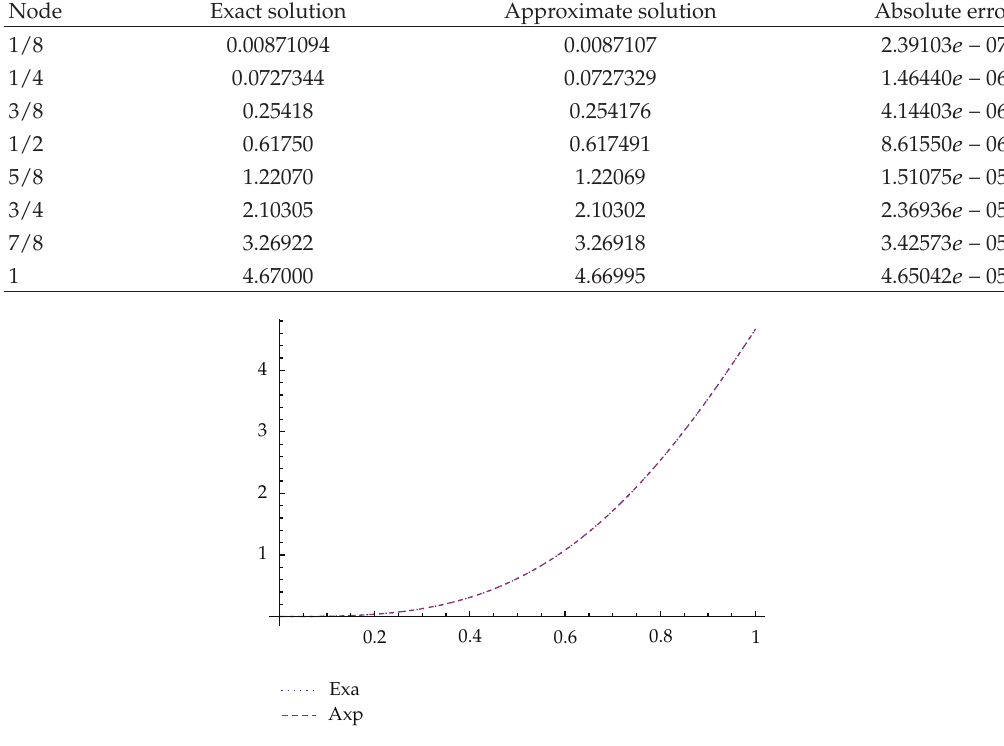
Figure 2: Comparison of the approximate solution u n (cid:6) x (cid:7) and u (cid:6) x (cid:7) at n (cid:9) 128 for Example 4.1. Table 2: The approximate solution in our method and in (cid:4) 41 (cid:5) for Example